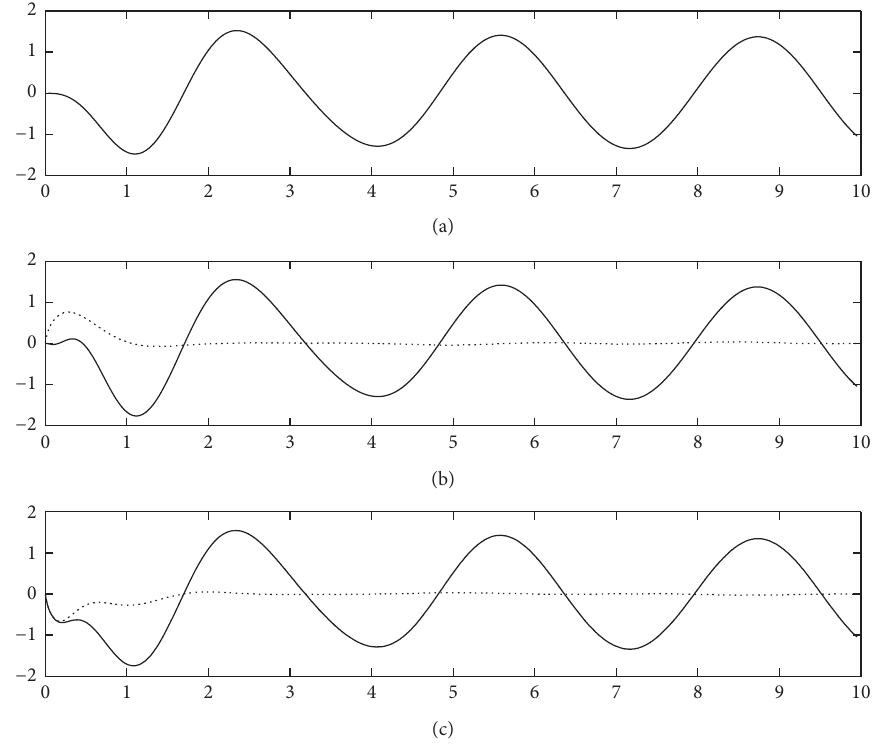
Figure 10: Tracking control of continuous-time chaotic system with trajectories (a) x